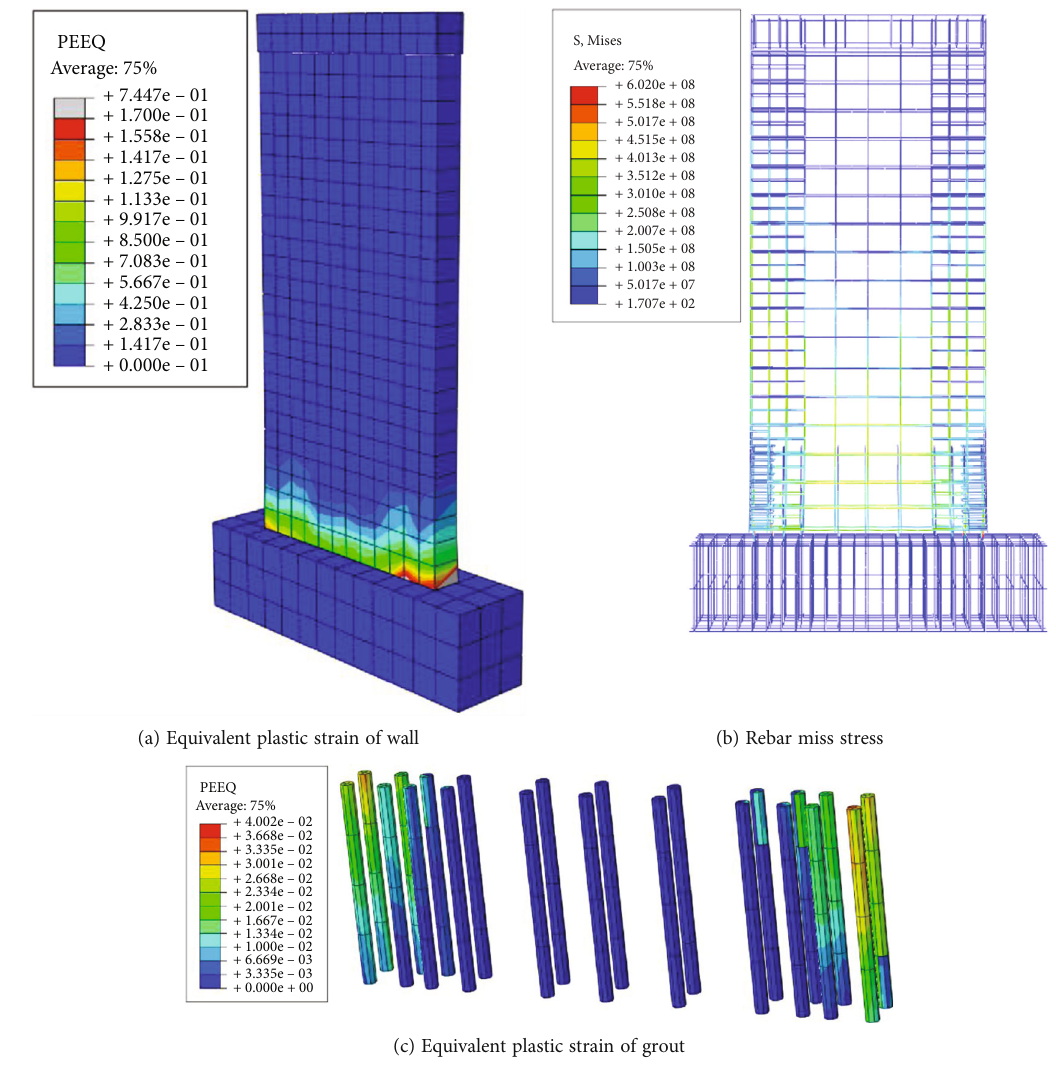
Figure 12: FEA stress results of specimen